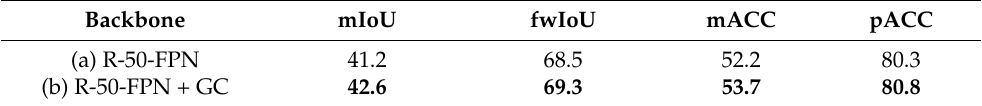
Table 4. Image semantic segmentation results on the COCO val2017 dataset. Here ResNet is abbreviated as “R”. Incorporating global contexts (GC) improves the quality of image semantic segmentation in all metrics. The number in bold means superiority compared to that of the baseline in the metric.